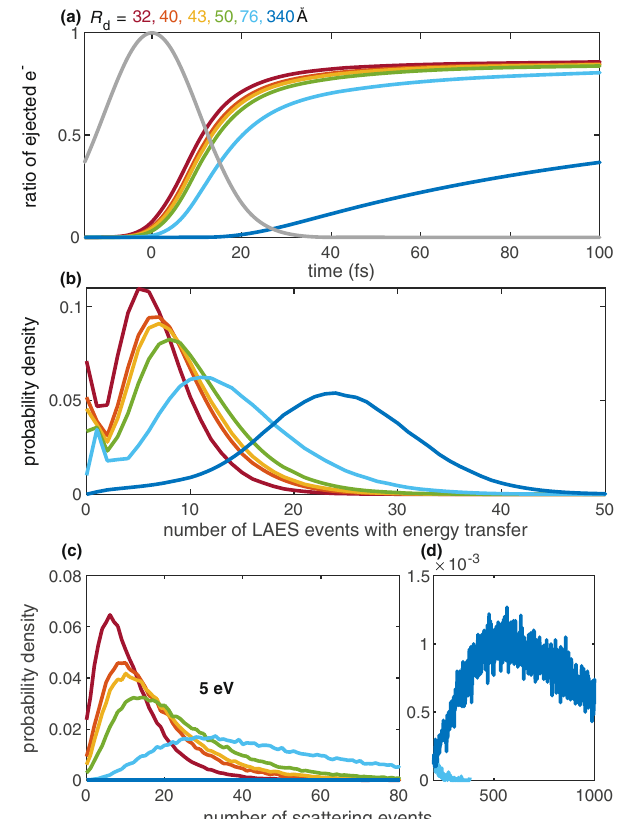
Fig. 3 LAES simulation of electron trajectories inside a He droplet for different droplet radii R d . a Ratio of ejected electrons (e − ) as function of time for different R d . For comparison, a Gaussian laser pulse envelope is shown in gray. b Number of laser-assisted scattering events with energy transfer as function of the droplet radius. c , d Probability distribution of total elastic scattering events, i.e., without laser fi eld and without temporal limit, for E kin = 5